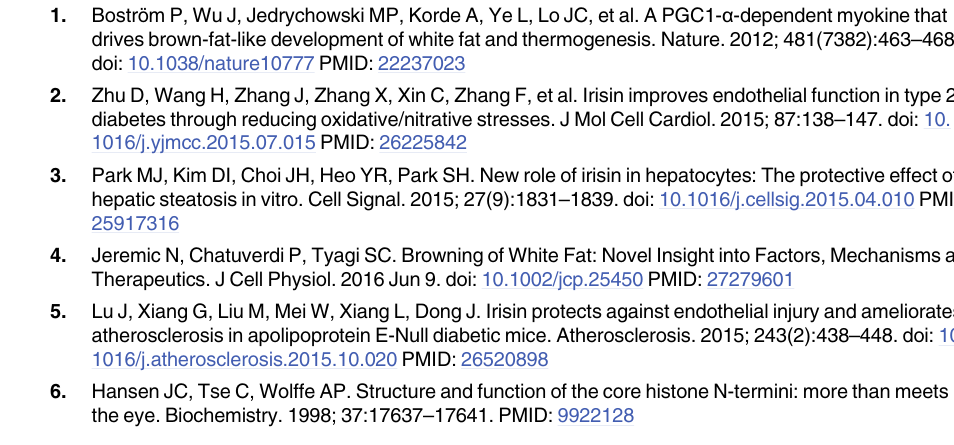
S2 Fig. Time-course of HDAC4 sumoylation following irisin treatment. The detailed meth- ods for immunoprecipitation and immunoblotting were described in the methods of main manuscript. Each blot represents three individual experiments. (TIF) S1 File. Measurement of mitochondrial membrane